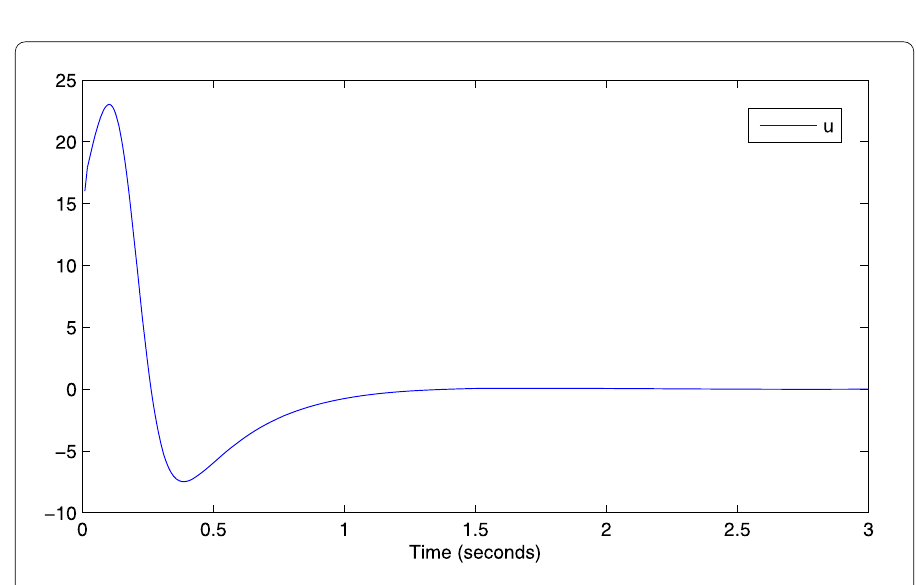
Figure 4 The state trajectories x 1 , x 2 , x 3 .